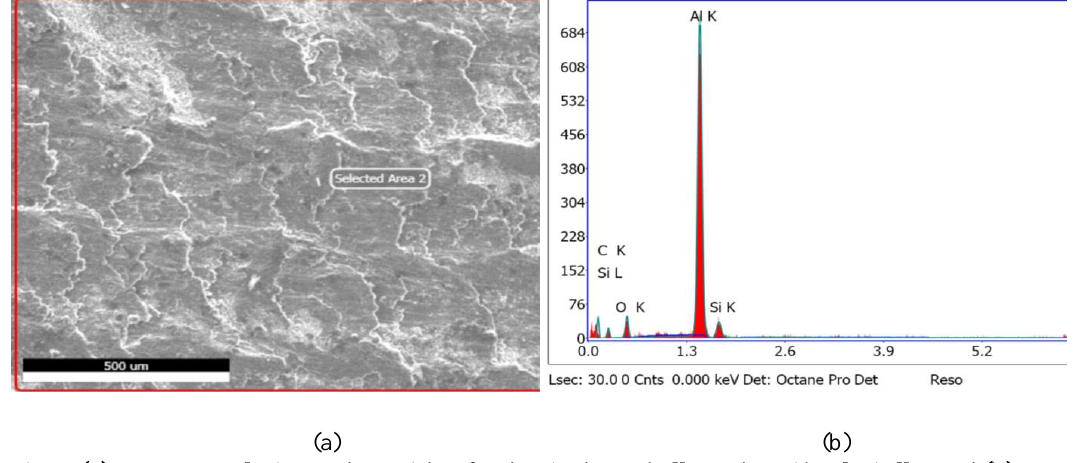
Fig. 6. (a) FE-SEM analysis 10% by weight of carbonized egg shell powder with Al-Si alloy and (b) EDX spectra of composite